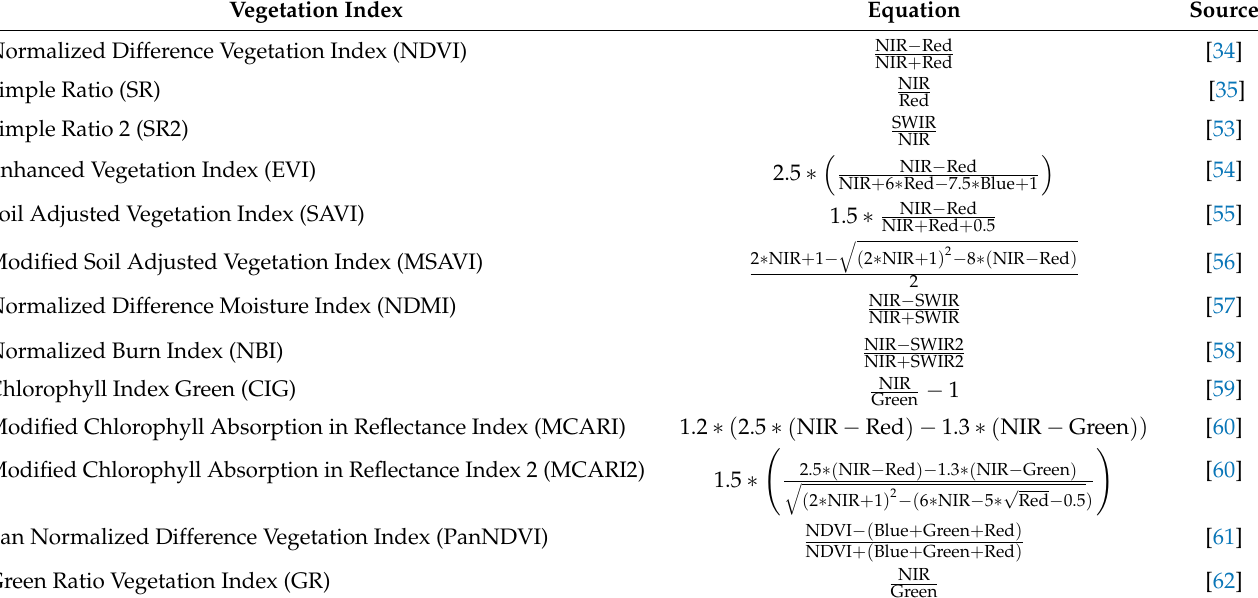
Table 1. Vegetation indices evaluated in the analysis. Near-infrared (NIR), band 4 in Landsat 5 and 7 ETM+. Shortwave- infrared (SWIR), band 5 in Landsat 5 and 7 Enhanced Thematic Mapper + (ETM+). Shortwave-infrared 2 (SWIR2), band 7 in Landsat 5 and 7